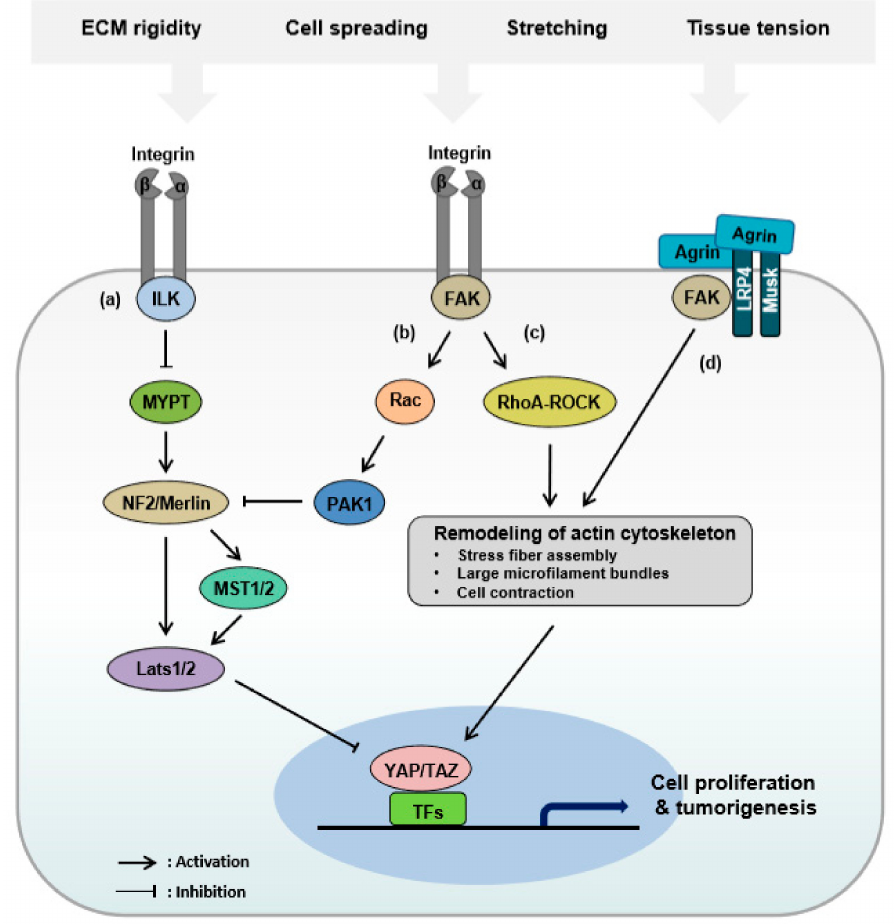
Figure 3. Schematic model of regulation of the Hippo pathway by numerous signaling pathways in cancer. ( a ) Integrin-ILK signaling inhibits MYPT1, leading to inactivation of the MST1 / 2-LATS1 / 2 kinase cascade, which triggers YAP / TAZ activation. ( b ) RAC1 and PAK1 phosphorylate NF2 that inhibits the interaction between YAP and NF2, resulting in YAP / TAZ activation. ( c ) Integrin-FAK signaling activates the RhoA-ROCK pathway to control remodeling of the actin cytoskeleton. ( d ) In response to ECM, Agrin enhances RhoA-ROCK-dependent actin cytoskeletal remodeling. As a later event, YAP / TAZ are translocated to the nucleus to interact with transcription factors (TFs), which drive profibrotic and tumorigenic e ff